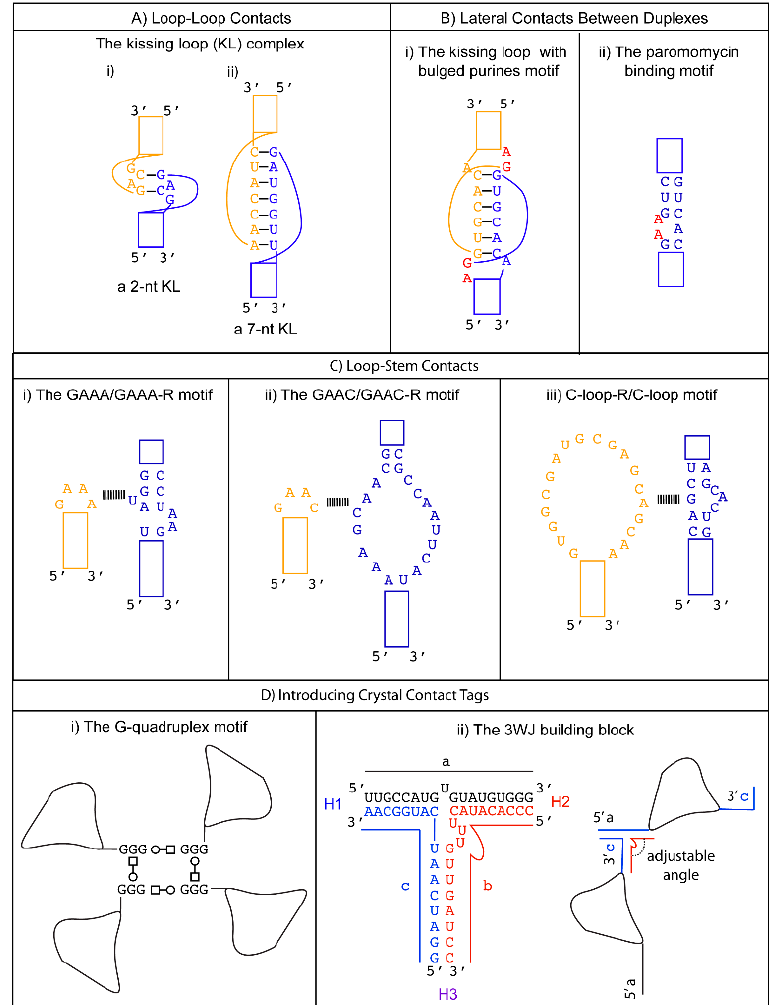
Figure 1. Summary of motifs discussed in the review. ( A ) Two examples of the kissing loop (KL) complex. ( i ) A 2-nt KL complex is formed between the H3 stem loop of the Moloney Murine leukemia virus [54]. ( ii ) A 7-nt KL complex is formed between stem loops I and II of the ColE1 plasmid [55,56]. ( B ) Design options to induce lateral contacts between duplexes. ( i ) A kissing loop complex with flipped-out purines from the dimerization initiation site of the HIV-1 genome [60]. ( ii ) The paramomycin binding site from the 16S rRNA of the E. coli ribosome can be utilized to introduce bulged adenines that can form tertiary interactions with a neighboring backbone [61,62].